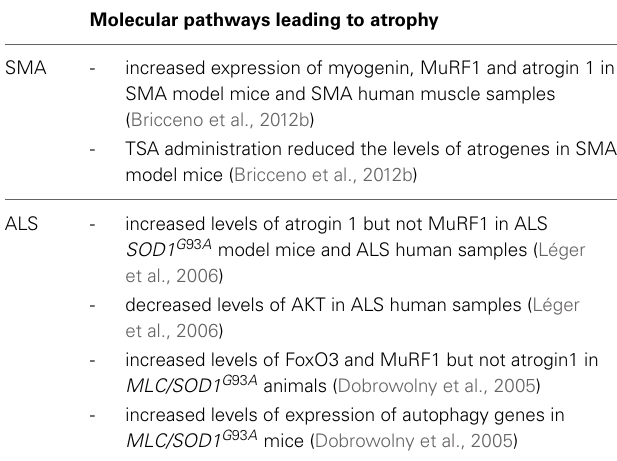
Table 1 | Summary of pathways leading to muscle atrophy in motor neuron